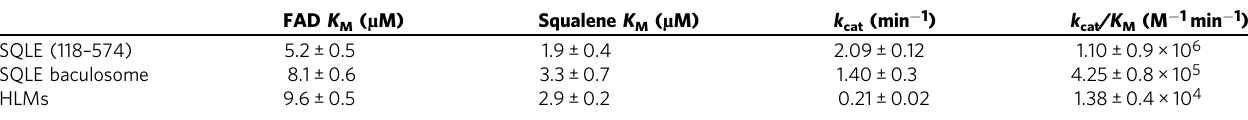
Table 1 Kinetic parameters for the SQLE reaction in different experimental models